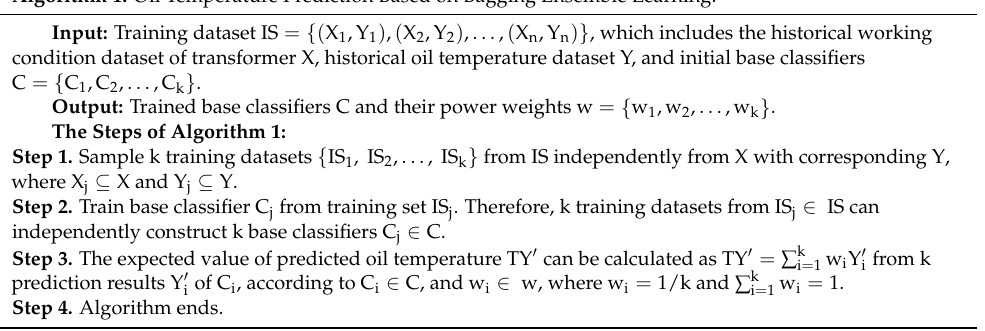
Algorithm 1. Oil Temperature Prediction Based on Bagging Ensemble